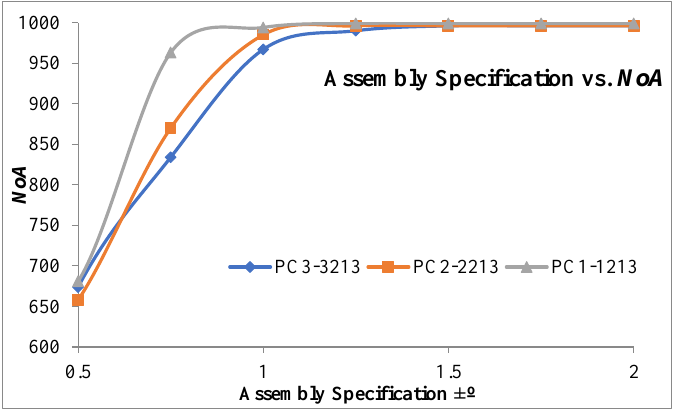
Figure 9. Assembly specification vs. NoA for various bin numbers—the 2213 process combination.